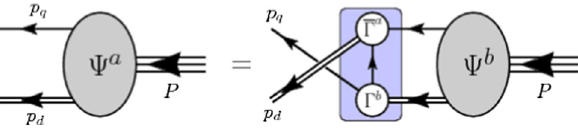
Fig. 2 Covariant Faddeev equation: linear integral equation satisfied by the matrix-valued Faddeev amplitude, Ψ , for a baryon of total momentum P = p d + p q , which expresses the relative-momentum correlation between the quarks and nonpointlike-diquarks within the baryon. The shaded rectangle is the Faddeev equation kernel: single line , dressed-quark propagator (Appendix A); Γ , diquark correlation amplitude (Sect.3); and double line , diquark propagator